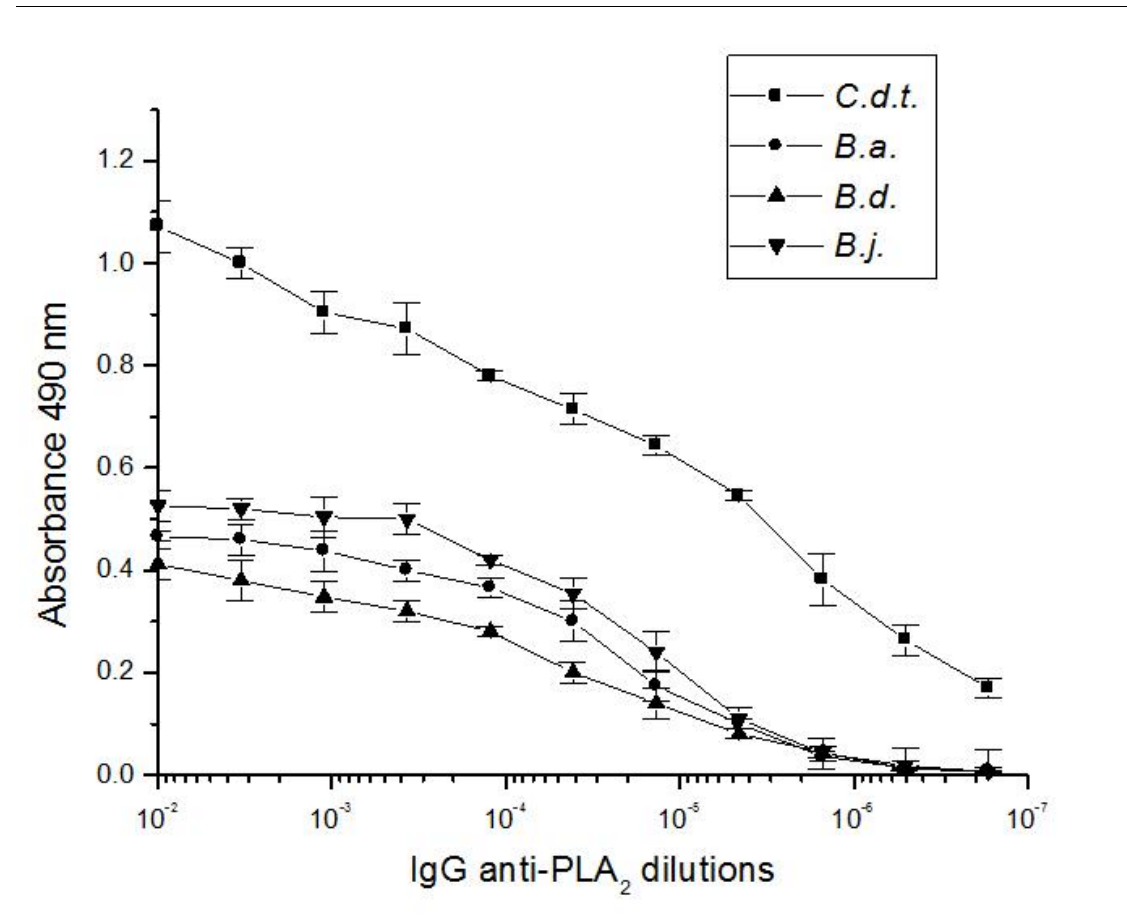
Figure 1 . Cross-reactivity determined by ELISA. Plates were coated with antigen (5 μ g/mL), incubated with rabbit IgG anti- C .PLA